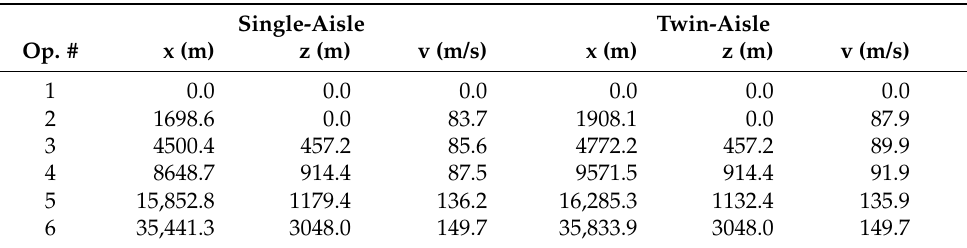
Table 2. Reference takeoff manoeuvre for the single- and twin-aisle aircraft: geometric and kinematic variables.